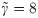
Sensitive T6S- individuals can dominate T6S+ competitors.(a-b) A ball of sensitive cells (blue) is surrounded by a thick layer of T6S+ cells (red). (a) Below a critical radius, the sensitive strain ball tends to shrink to extinction; (b) above it, the ball tends to expand. This behavior is demonstrated for 1D, 2D, and 3D. (c) Heat map of the probability that a 2D sensitive domain surrounded by T6S+ competitors achieves steady growth, as a function of sensitive strain growth rate and initial radius of the sensitive domain. Dashed curve indicates predicted critical parameter values based on Eq. S1. Attack rate γ˜=8; interpolated from 80,250 simulations with timestep multiplier λ = 500. (Sensitive population either decreased or increased from near the outset of each simulation; consequently, simulations were run only until the sensitive population changed by a factor of three in either direction.) (d) Comparison of growth rate observed in single-domain sensitive 2D growth simulations (y-axis) to the values predicted for this regime in Eq 1 (x-axis). Points represent the average, by sensitive population, across all simulations with the same parameters (20 per condition; λ = 2). Color represents domain radius; black line is y = x.